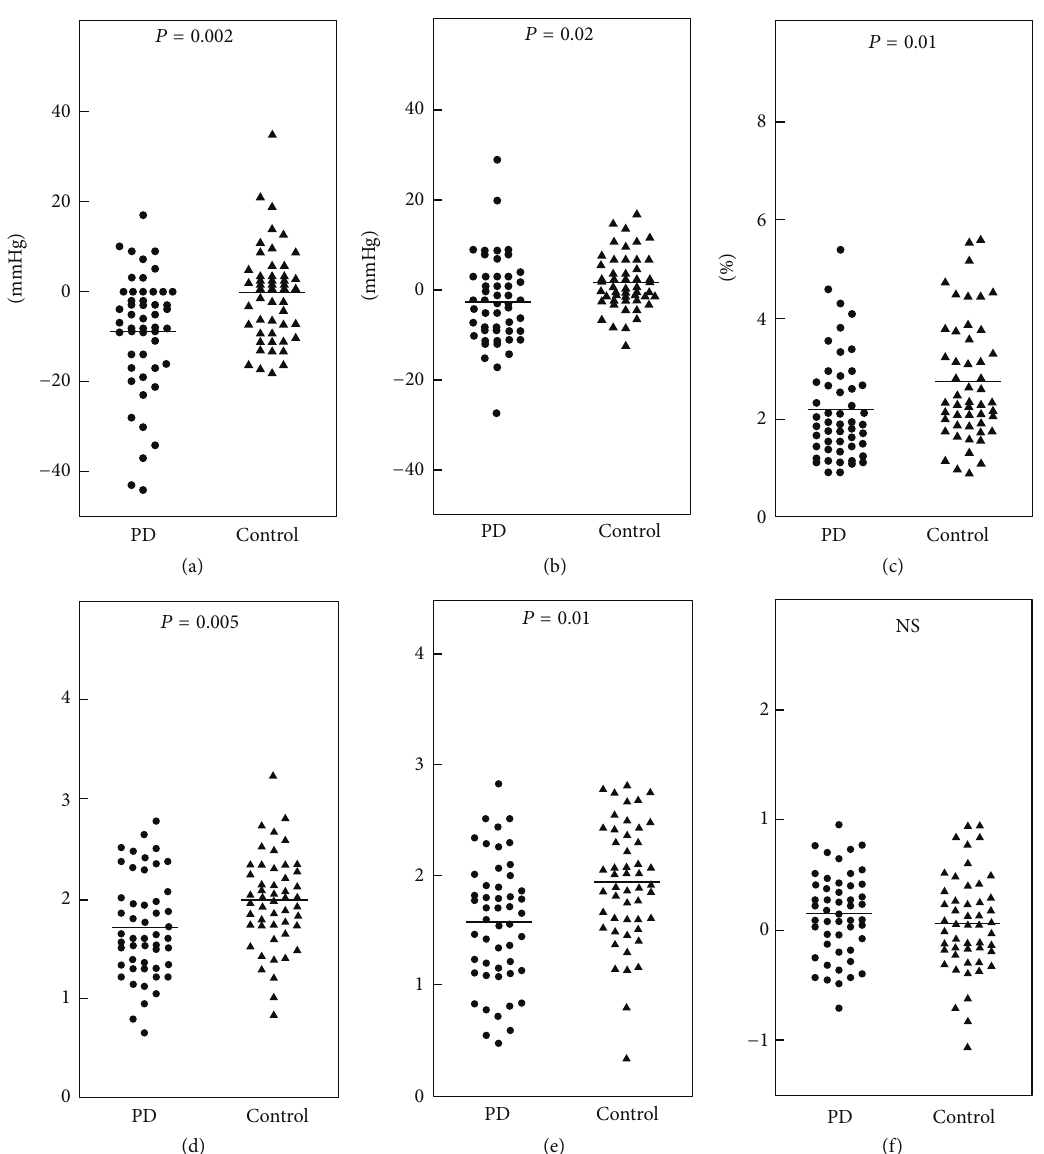
Figure 1: Systolic (a) and diastolic (b) blood pressure changes during the head-up tilt test, CV R high-frequency (HF) component (e), and LF/HF ratio (f) in patients with Parkinson’s disease (PD) and healthy control subjects. The values of LF, HF, and the LF/HF ratio are presented as logarithmic transformations. Bars indicate